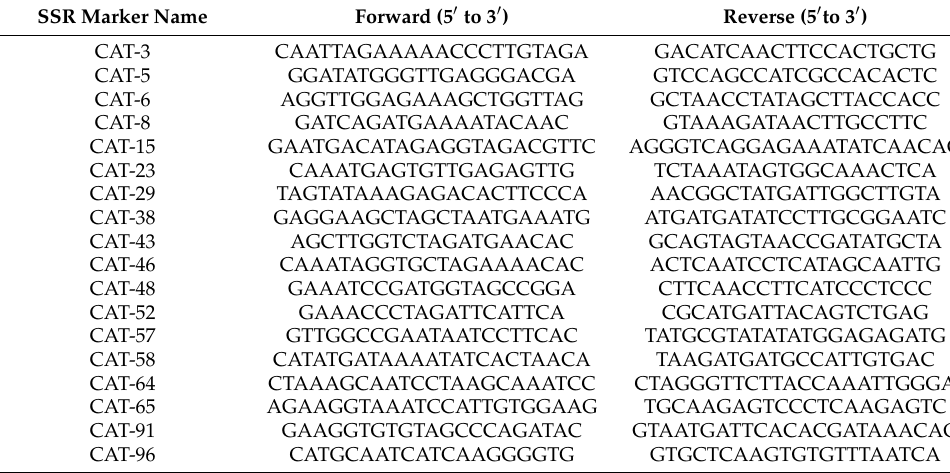
Table 2. SSR Primers and sequence information.